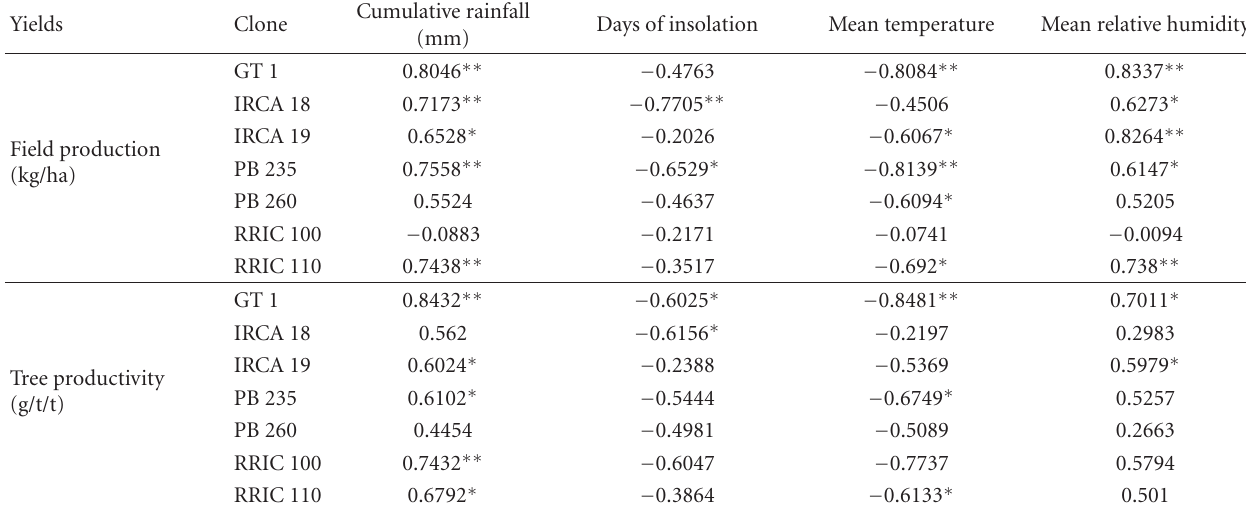
Table 1: Correlation coe ffi cients between yield and weather variables.